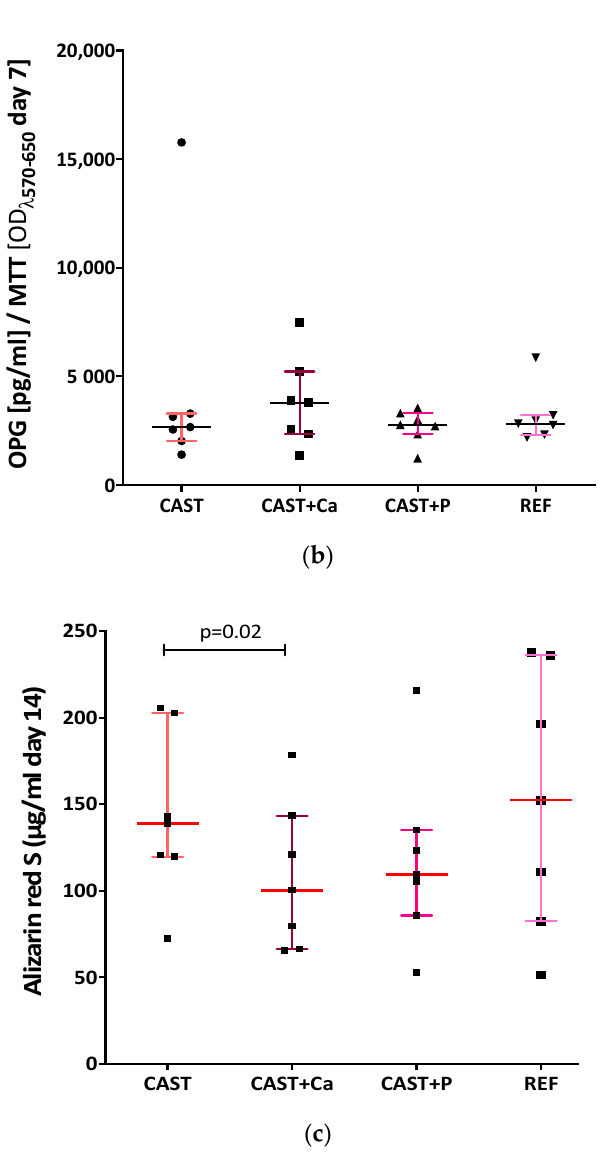
Figure 7. Detection of in vitro mineralization and protein secretion. ( a ) CICP Elisa for collagen type I synthesis after osteoblast cultivation for 3 and 7 days. Influence of different surfaces on collagen type I synthesis was tested by a two-way ANOVA with Bonferroni post hoc test. ( b ) OPG Elisa results of osteoblast cultures after 7 days cultivation. Data were analyzed by using Kruskal–Wallis and Dunn’s post hoc tests for statistical significance. ( c ) Alizarin red S staining was used to analyze the mineralization of osteoblasts’ seeded specimens and the effect of Ca- or P-Ion coated surfaces after 14 days. Statistical analysis was done by a one-way ANOVA with a Tukey post hoc test. The significance level was set to p ≤ 0.05. Values are shown as scatter plots with Median and interquartile range. Ca- ion and P-ion implantation by ion dose 1 × 10 − 16 cm 2 , implantation energy 30 keV; n = 7.